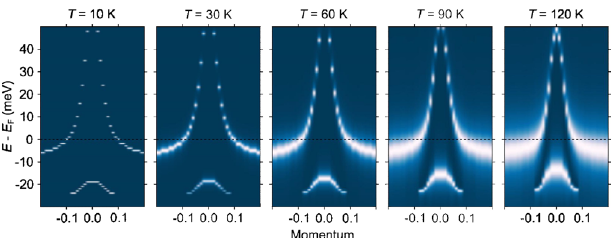
FIG. 5. 4 f spectral functions corresponding to the crystal electrical field ground state calculated for temperatures T ¼ 10 , 30, 60, 90, and 120 K around the “ neck ” feature of the BZ. The calculations are performed within the renormalized band structure approach which has already been successful in calculating the large FS of YbRh 2 Si 2 [Fig. 2(a)] and its change as a function of magnetic fields [40]. The calculated spectral function shows only a weak T dependence. The necks of the BZ remain open until well above 120 K, in accordance with the experimental result. To better visualize the changes in the distribution of 4 f spectral weight, the spectra are normalized to the maximum value at the temperature under